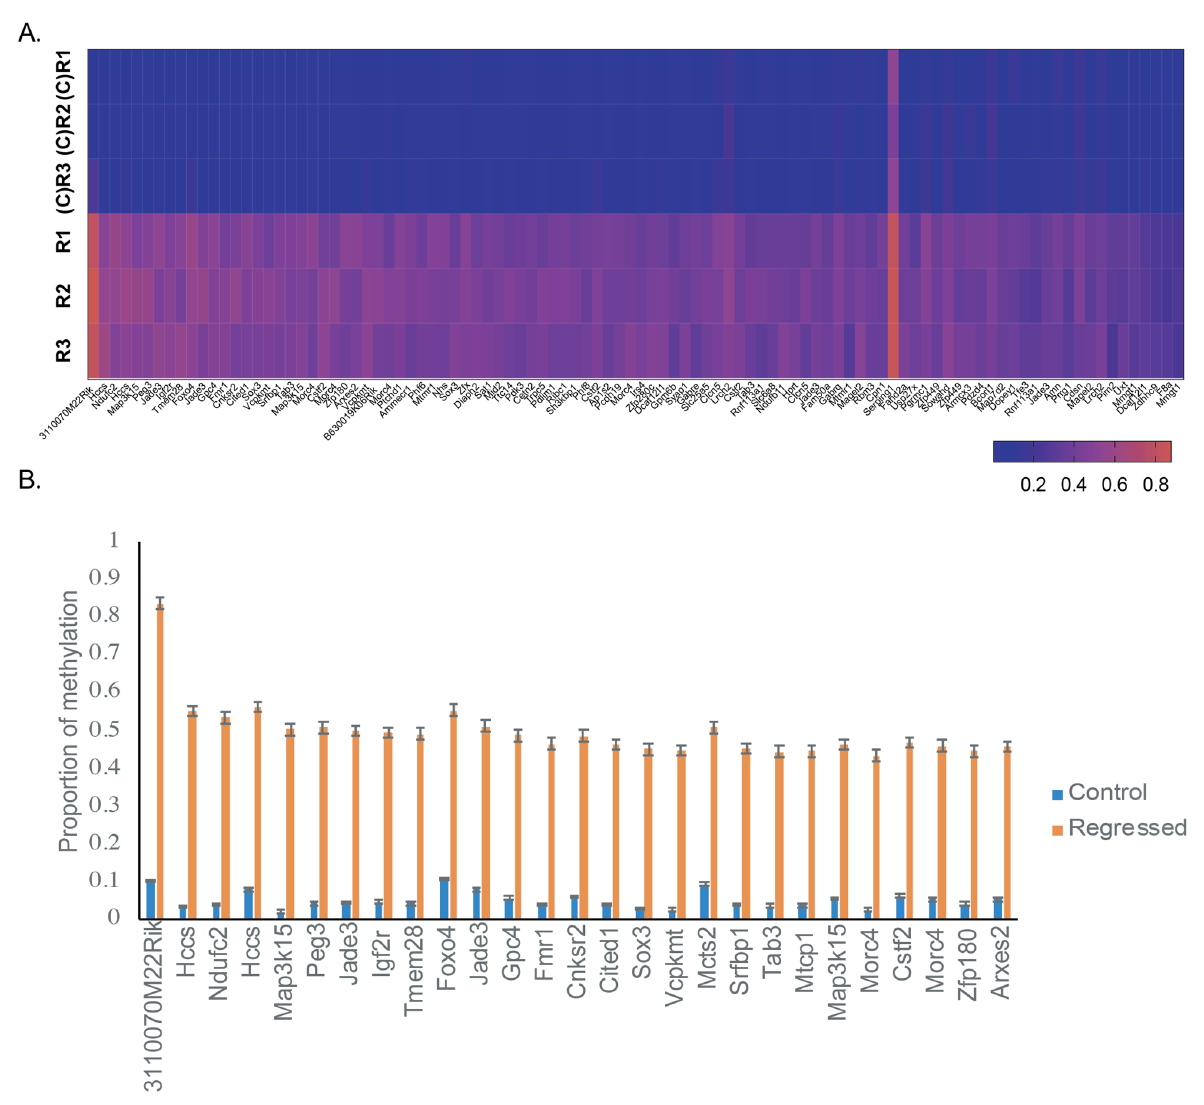
Figure 3. Extensive hypermethylation identified in regressed skin. ( A ) Individual DMFs in the core promoter region of genes with >20% methylation difference between regressed and control groups by individual sample. Five genes with insufficient data to calculate methylation in at least one sample have been removed from the heatmap ( B ) Individual DMFs in the core promoter region of genes with >40% methylation difference between regressed and control groups. More than one DMF was identified for some genes. Error bars display standard error of the mean.